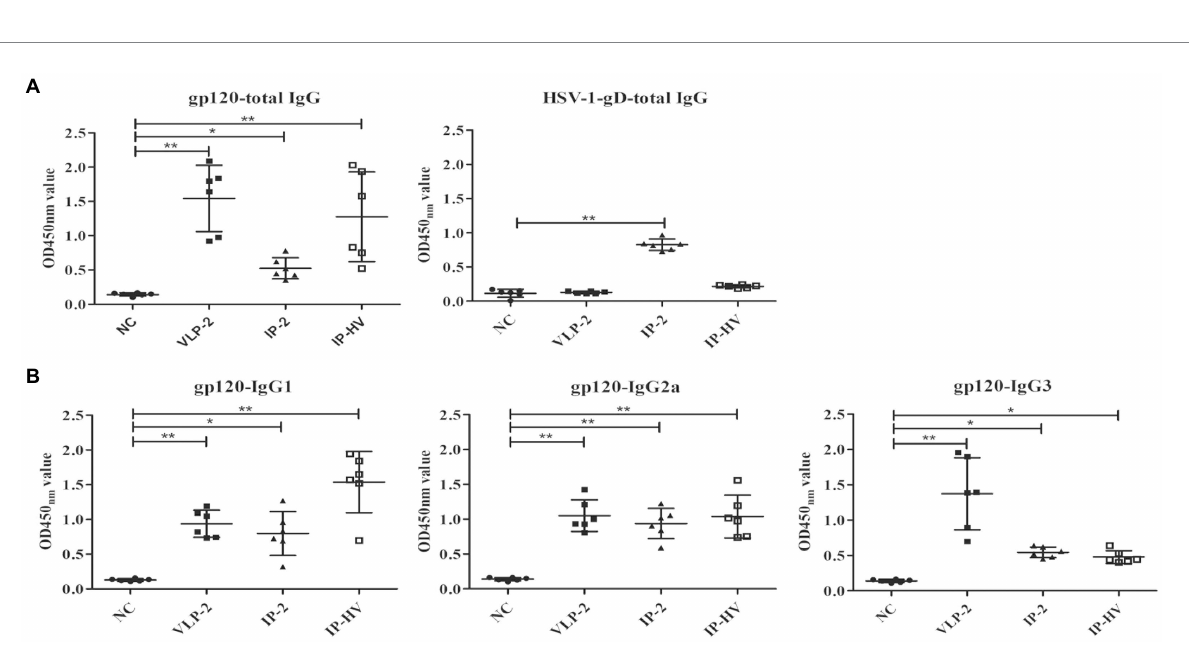
FIGURE 6 Antibody responses elicited by different immunization regimens. The serum samples were collected from mice following different immunization regimens 56 days after the first injection and antigen specific humoral immune responses measured by ELISA. Pre-immune sera of each mouse were used as negative control. Serum dilution is 1:10 5 for HSV-1 gD, and 1:10 3 for all other antigens. (A) Total IgG responses specifically against gp120 (a) and HSV-1 gD. (B) IgG subtype antibodies against gp120, including IgG1, IgG2a, and IgG3. Mock-infected mouse servs as the negative control (NC). * p < 0.05, ** p <